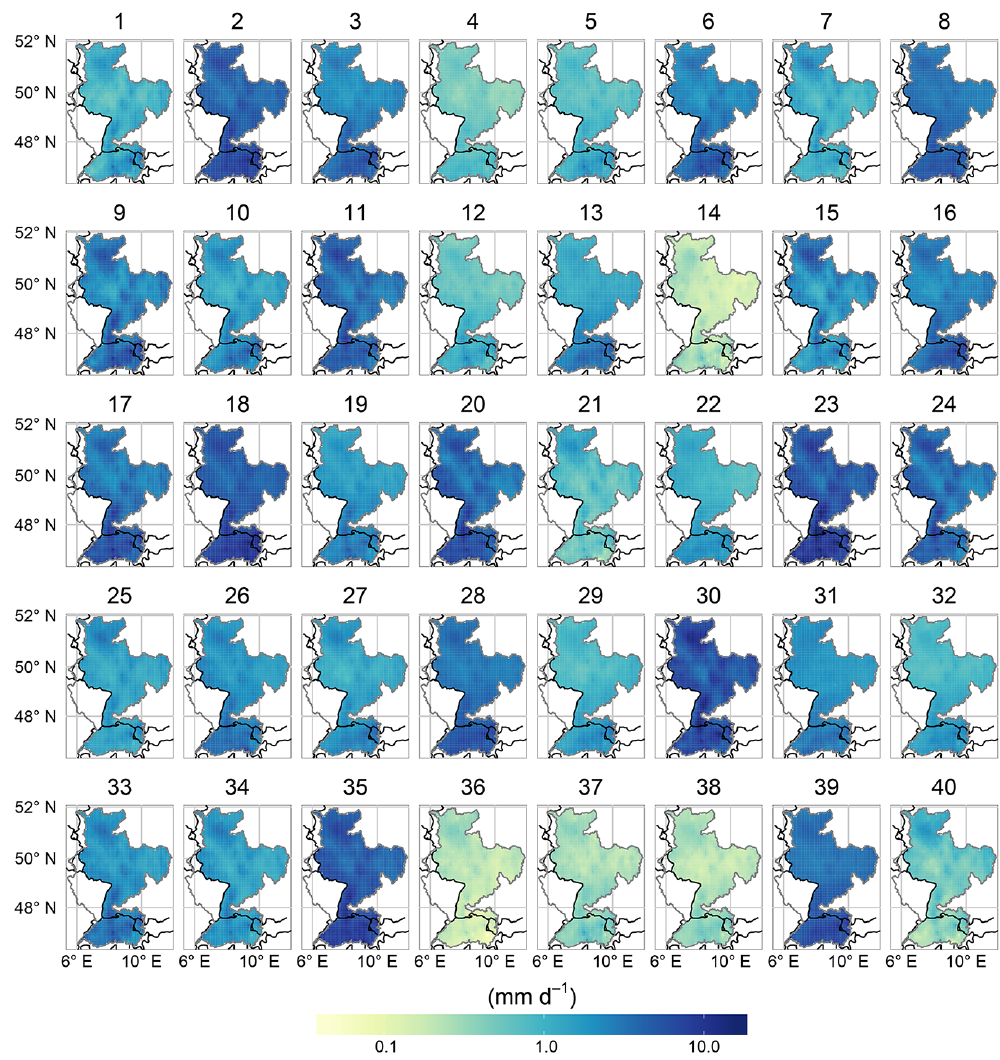
Figure A2. As in Fig. A1 but for daily